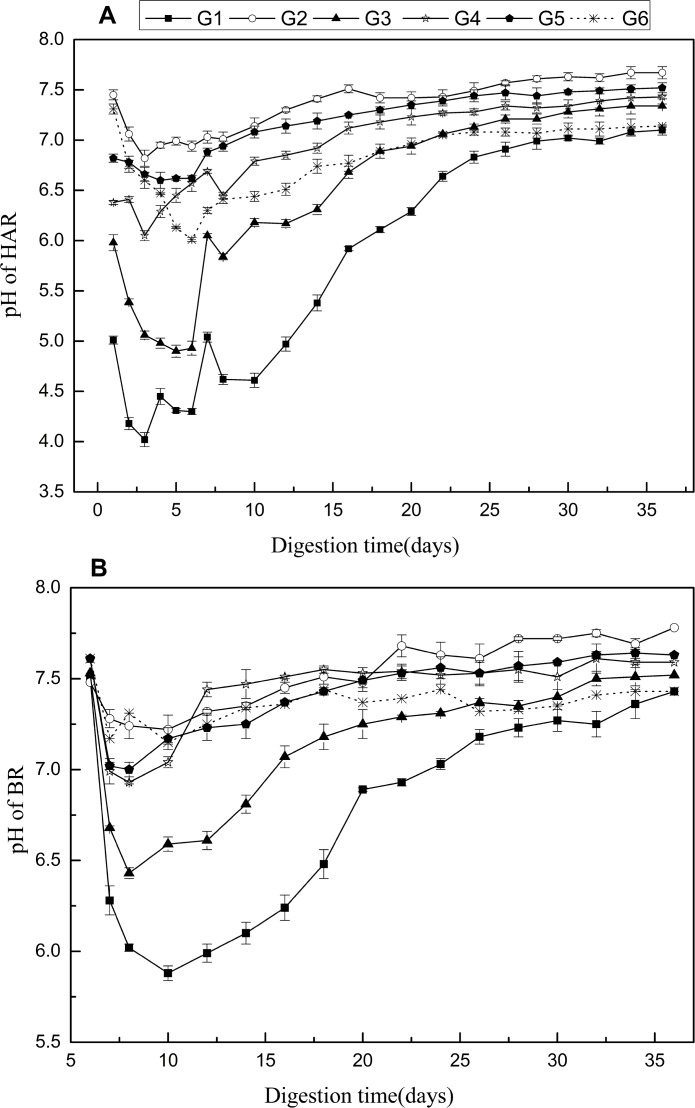
pH changes in HAR (A), pH changes in BR pH (B).